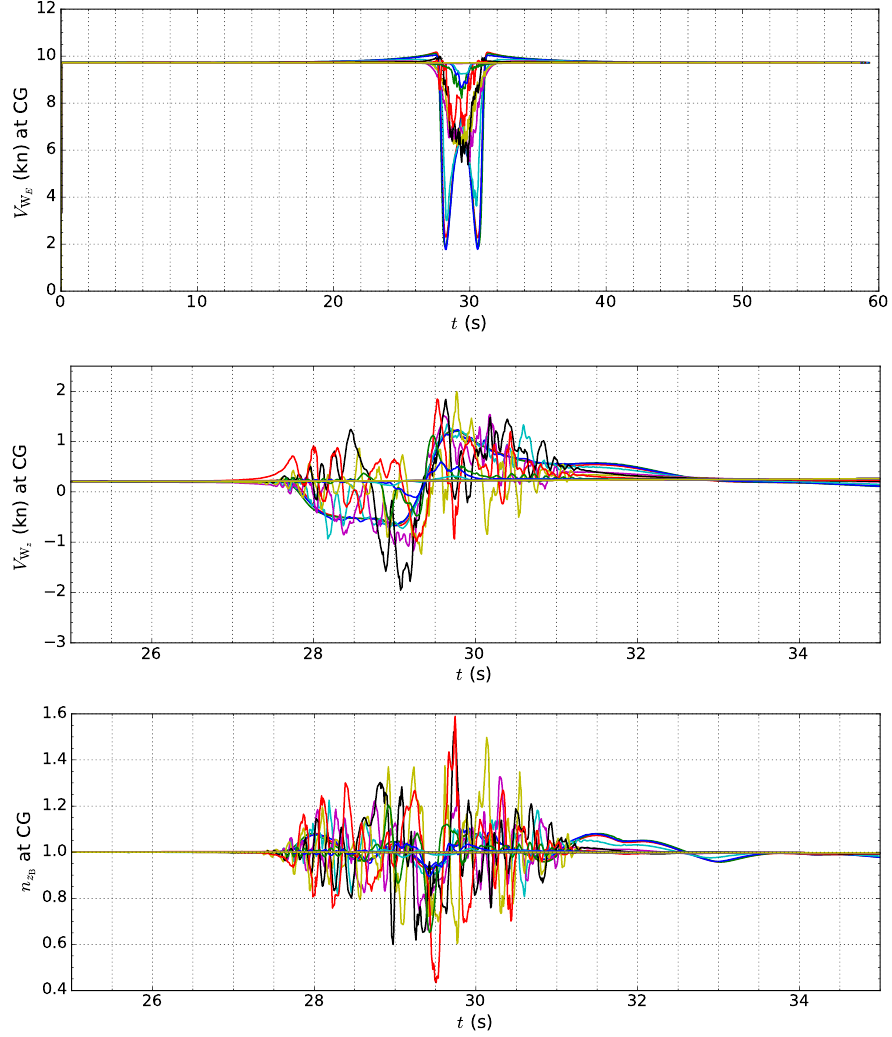
Figure 8. Time histories for case ALM 11 and S ET 2. ( Top ) wind velocity component along the east direction, which is not dependent on the aircraft attitude. The whole trajectory, from start to end, is covered in the plots. The wake encounter phase is clearly rendered by the pronounced decrease in magnitude, about midway through the trajectory. For a few trajectories closer to the rotor disk, it is possible to distinguish the two separate wakes due to the actual blades; ( Middle and Bottom ) wind velocity component and aircraft normal load factor along the body-fixed z B axis. These quantities depend on the actual attitude of the aircraft and only the wake encounter section of the trajectory is reported. The trajectories that are closer to the wind turbine are characterized by a lower frequency in the oscillations of both V W and n z , due to the stability of the near B z